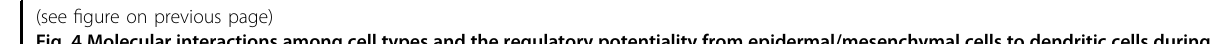
(Fig. 4I). Thus, these results suggested that the enhanced secretion of IL-17B from dermal mesenchymal cells might actively contribute to the biological functions of immune cells during psoriasis.